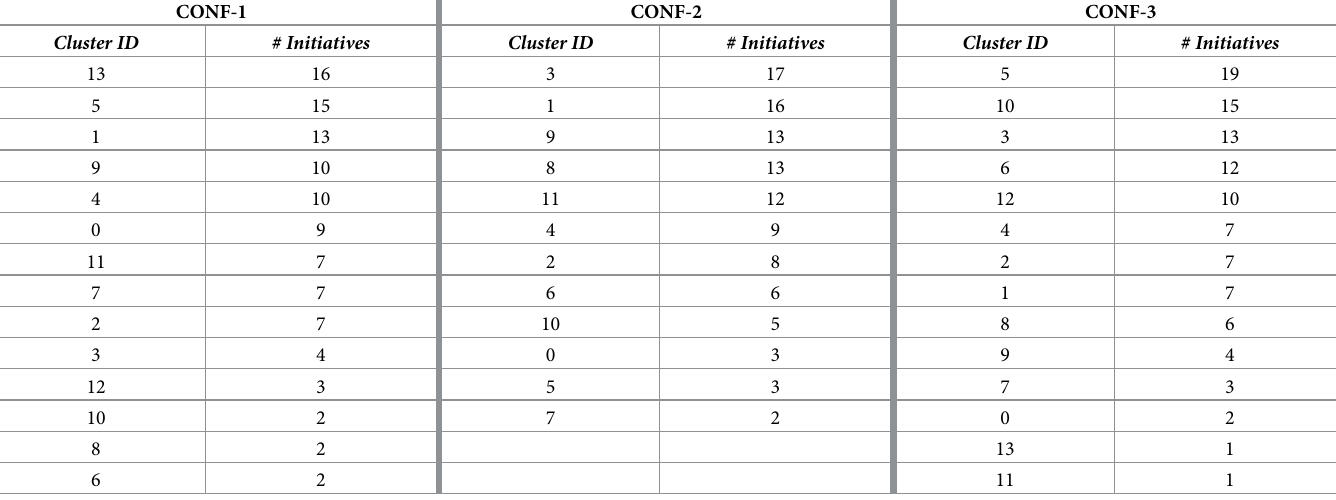
Table 4. Distribution of initiatives among the clusters generated by the three configurations.